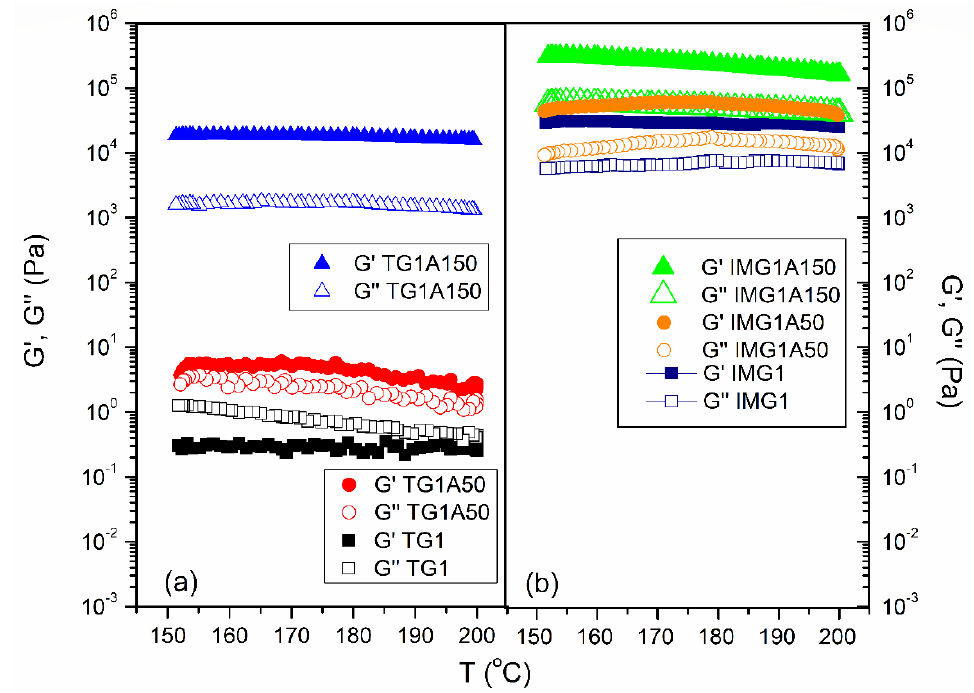
Figure 7. The change of storage ( G′ ) and loss ( G″ ) modulus of ( a ) TG1, TG1A50, TG1A150 and ( b ) IMG1, IMG1A50, IMG1A150 at different temperatures.